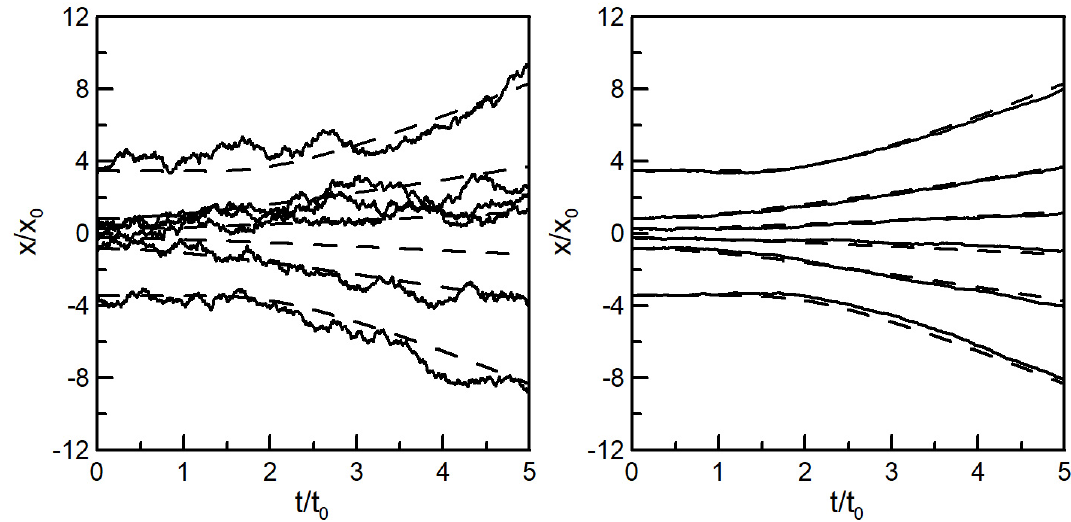
Figure 5. The trajectories of Brownian motions of fluid elements for R e = 10. The left and right panels represent the results for α A = 0.1 and 10, respectively. Six different initial positions are chosen by q ( 0 ) = − 3.45, − 0.84, − 0.25,0.25,0.84 and 3.45. For the sake of comparison, the streamlines of the fluid are shown by the dotted